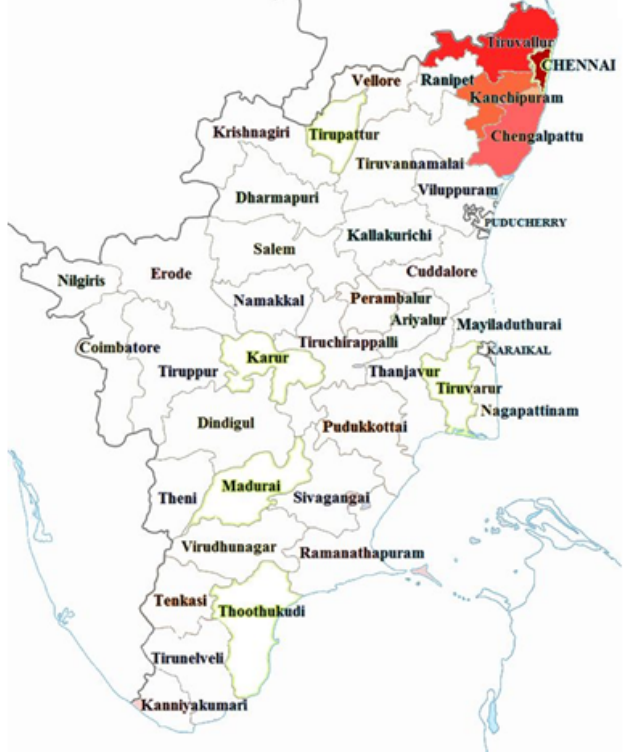
Figure 2. Constructed study site “Chennai-Metro-Merge,” combining Chennai District with the three bordering districts Chengalpattu, Kanchepuram, and Thiruvallur. The estimated total population of the constructed single geographical zone by 2020 is